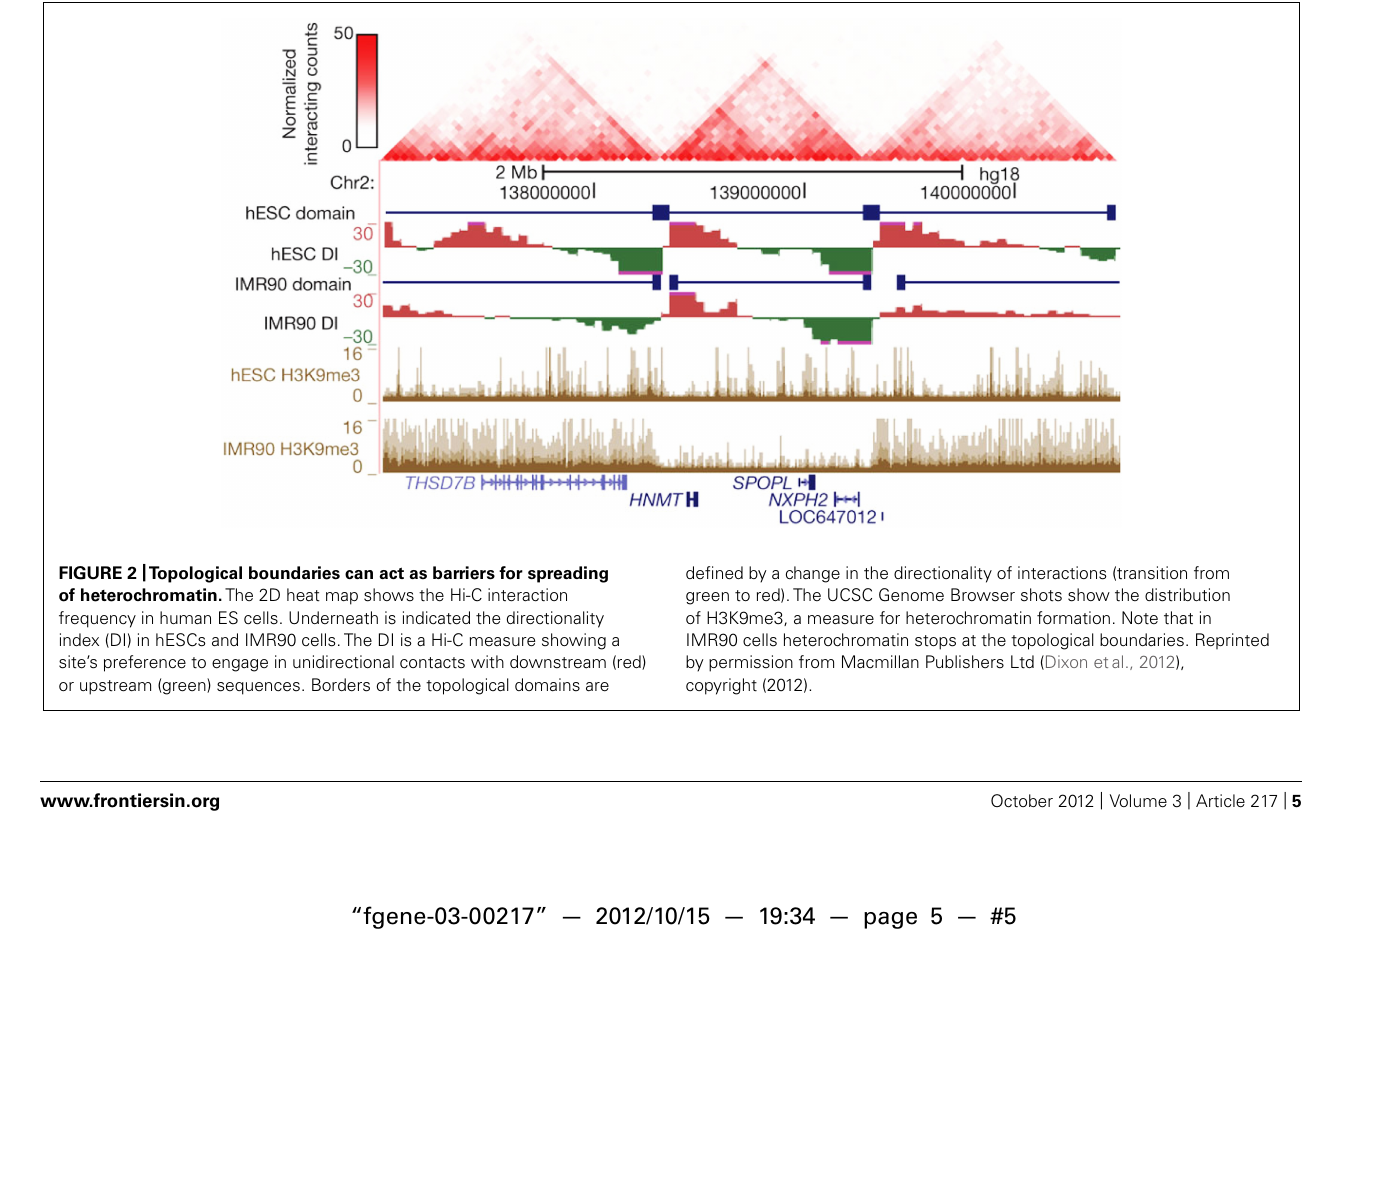
defined by a change in the directionality of interactions (transition from green to red).The UCSC Genome Browser shots show the distribution of H3K9me3, a measure for heterochromatin formation. Note that in IMR90 cells heterochromatin stops at the topological boundaries. Reprinted by permission from Macmillan Publishers Ltd (Dixon etal., 2012), copyright